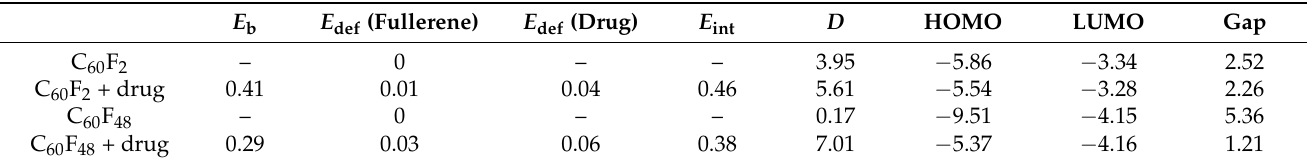
Figure 2. Optimized geometry of the chloroquine molecule loaded on fluorinated fullerenes ( a ) C 60 F 2 and ( b ) C 60 F 48 . Table 1. Calculated geometric and energetic characteristics of fluorinated C 60 loaded by chloroquine drug. Binding energy E b (eV), fullerene and drug deformation energies E def (eV), interaction energy E int (eV), dipole moments D (Debye), frontier molecular orbitals HOMO and LUMO (eV) and HOMO– LUMO gaps (eV) are